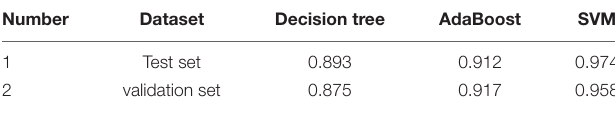
TABLE 2 | Test results of 3